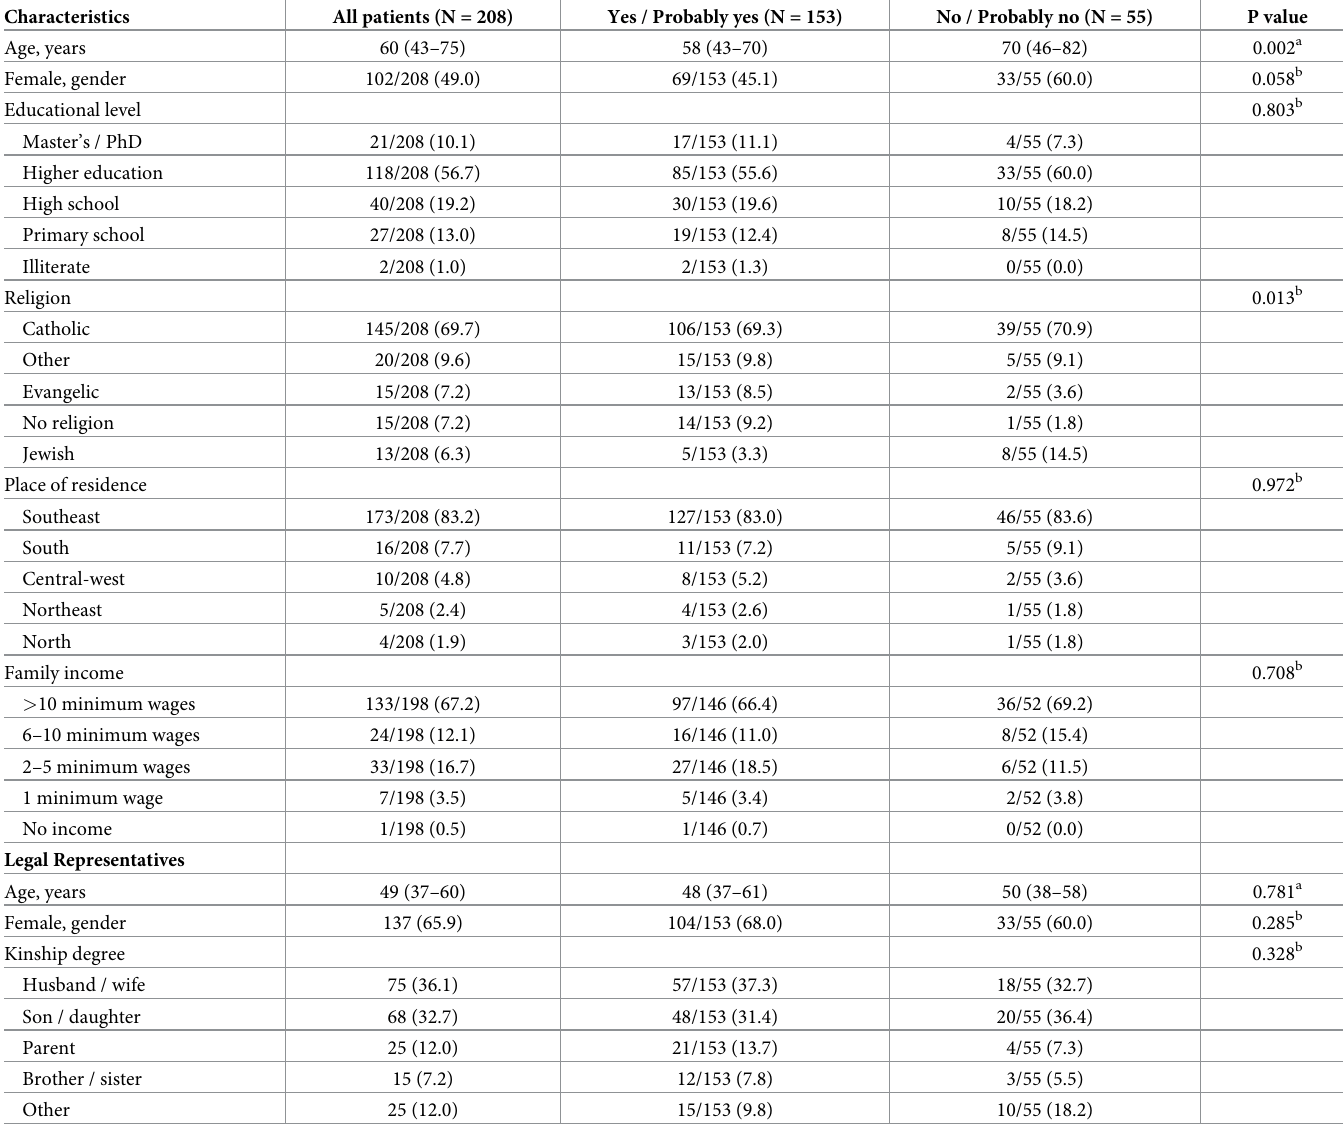
Table 1. Characteristics of study participants according to their willingness to participate as volunteers in a scientific study. Data presented as median (interquartile range) or n º /total (%) # .